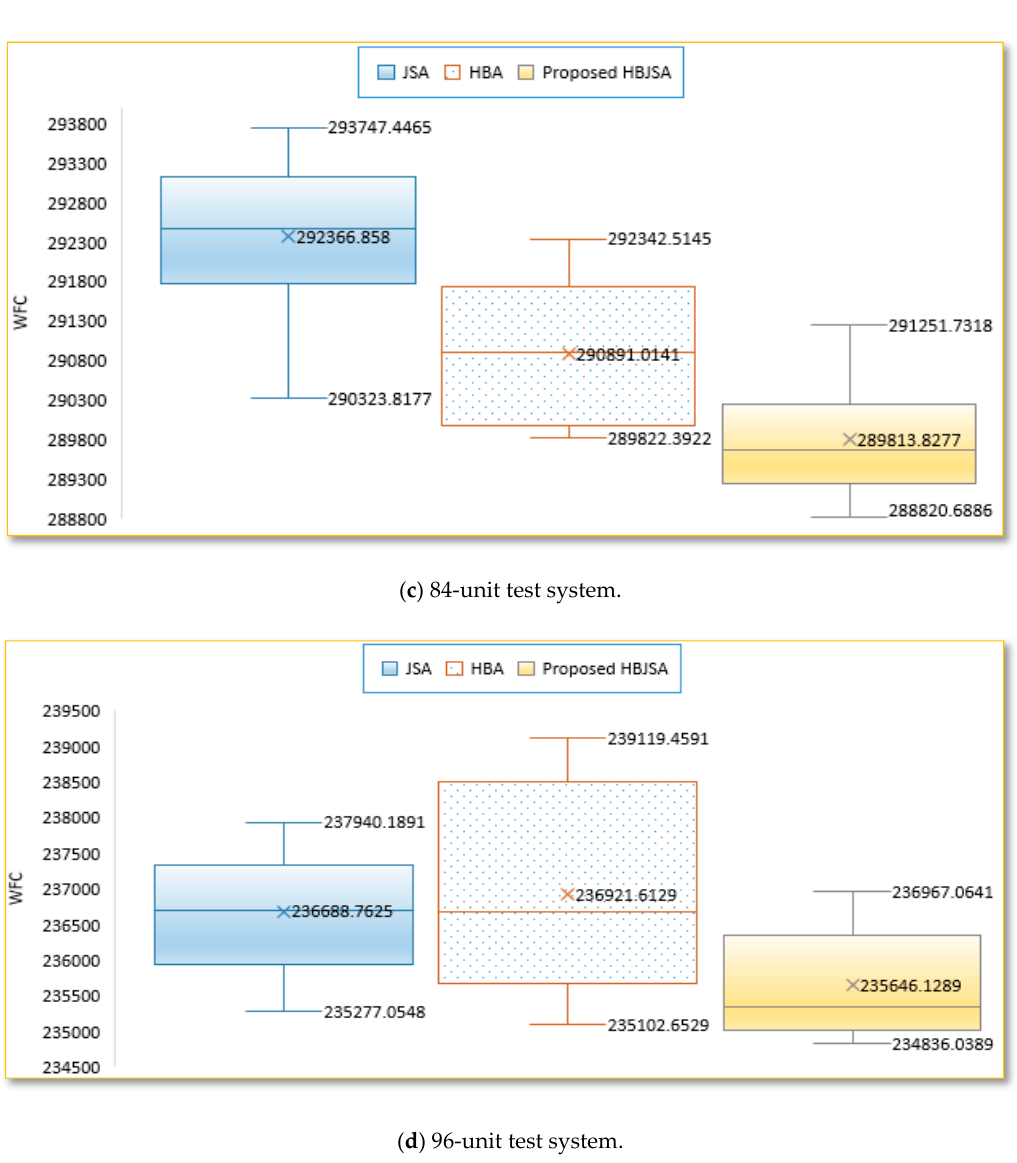
Figure 9. Whiskers box plot for the proposed HBJSA versus HBA and JSA for solving the CHP economic dispatch